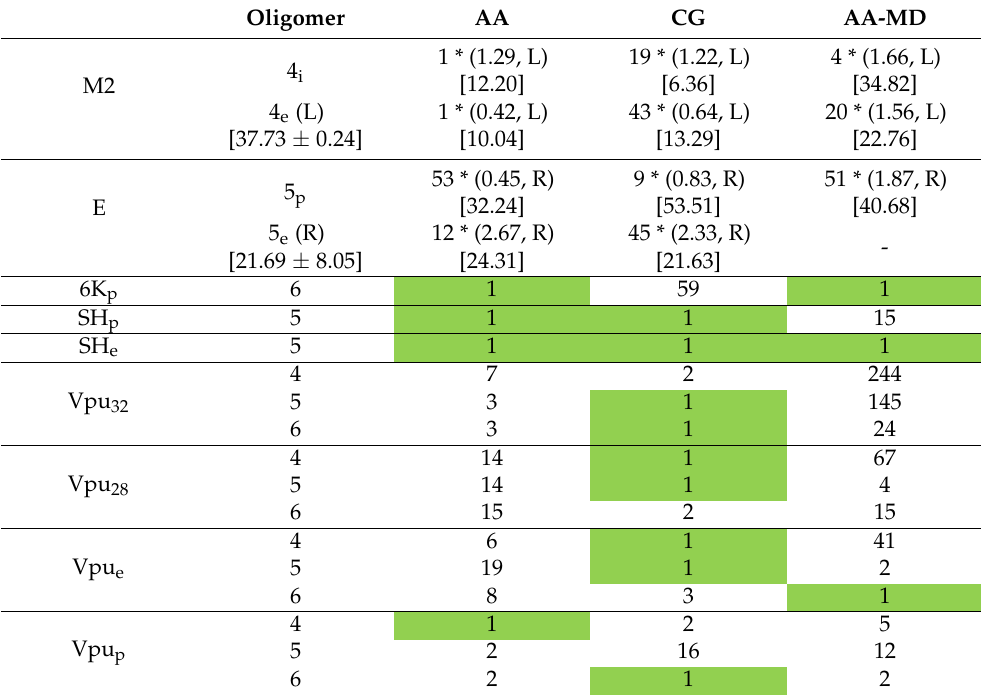
Table 1. Ranking of the oligomeric structures based on the estimated binding energy of M2 i , M2 e , E p , E e , 6K p , SH p , SH e , Vpu 28 , Vpu 32 , Vpu e and Vpu p . The green-colored tiles indicate that the marker-residues (mr’s) are pointing inside irrespective of the handedness. Numbers indicate the absolute rank according to the structure for which mr’s are within the pore and the handedness of the bundle is correct. The subscripts indicate: e = structures or sequence used from experimental sources; p = predicted sequences that are used to model the transmembrane domain (TMD); 32 and 28 = number of amino acids used for modeling ideal TMDs. The following ideal models are used: AA = all atom models; CG = coarse grained models; AA-MD = all atom models used in 200 ns MD simulation. The “oligomers” are sorted according to the number of TMDs forming the bundle. The “-” indicates that a structure cannot be identified in which the mr’s are pointing into the pore. Numbers in brackets represent the root mean square deviation (RMSD) values in nm of the structures with reference to the experimental structures. Letters R and L refer to right- and left-handed bundles, respectively, of the crystal structures. Numbers in squared brackets represent the tilt angles ( ◦ ), given as average with standard deviation for M2 e and E e proteins. “*” refers to models with the correct handedness and mr pointing into the bundle.